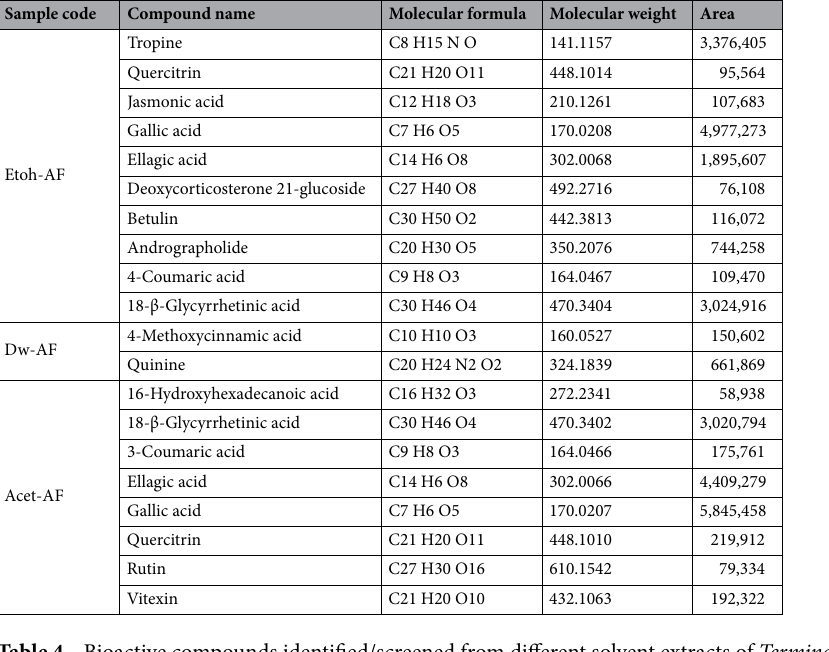
Table 4. Bioactive compounds identified/screened from different solvent extracts of Terminalia Arjuna